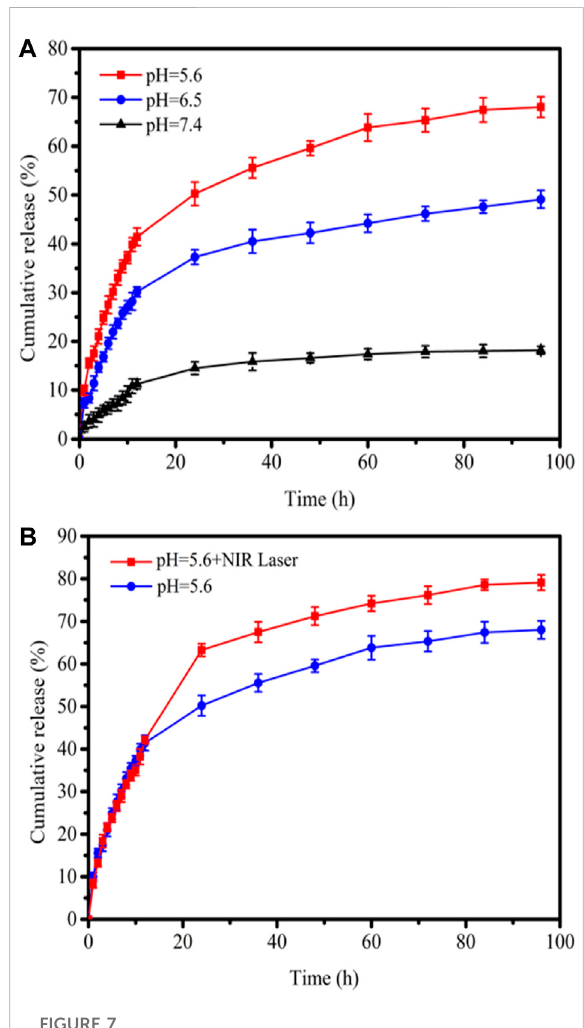
FIGURE 7 (A) DOX drug release pro fi les at pH 7.4, 6.5, and 5.6; (B) Drug release pro fi les with/without 808 nm laser irradiation at pH